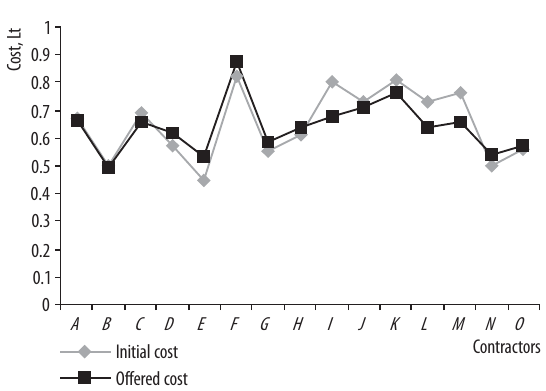
Multicriteria Evaluation of Apartment Blocks Maintenance Contractors